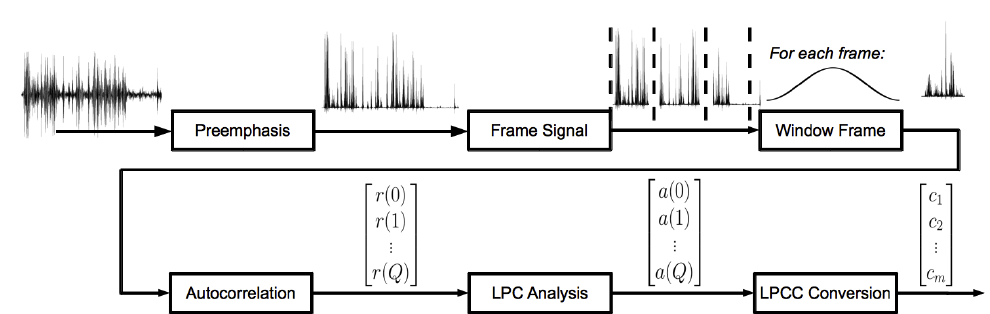
Figure 2. Linear predictive cepstral coefficient (LPCC)